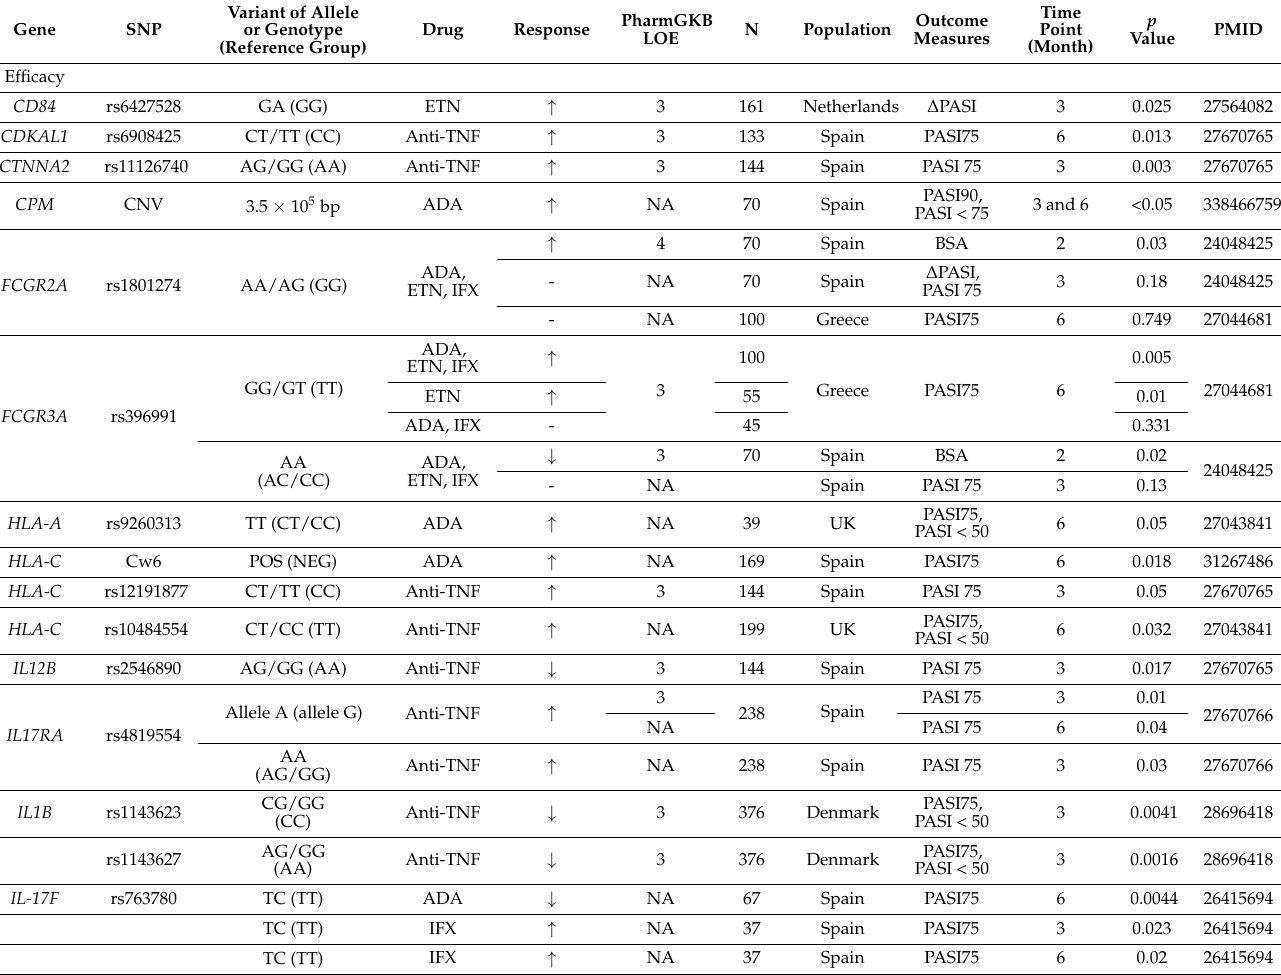
Table 4. Genetic polymorphisms associated with response of TNF antagonist in patients with